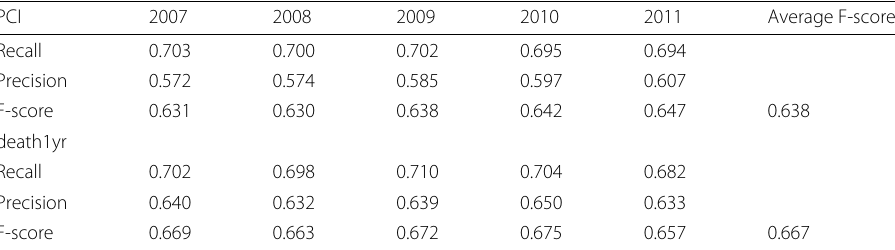
Table 12 Classification results of GBDT for death1yr and PCI in